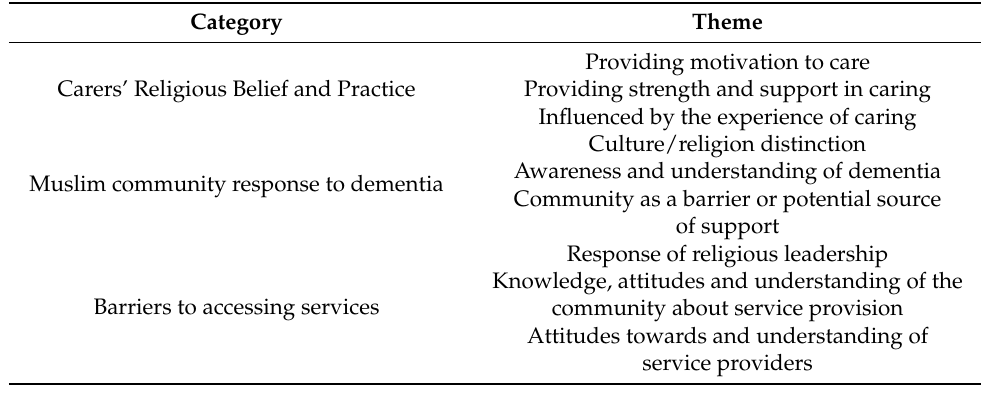
Table 1. Categories and